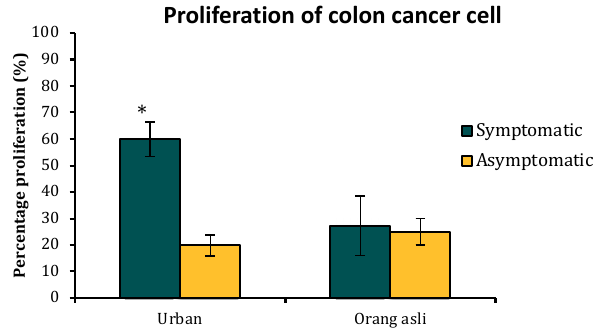
Figure 7. The proliferation of HCT 116 colon cancer cells when treated with solubilized antigens from Blastocystis sp. isolated from urban and orang asli individuals . Colon cells at the density of 1000 cells in 100 μ L were treated with 0.01 μ g/mL of antigen. The proliferation of cancer cells was seen only with isolates obtained from urban symptomatic individuals. Values are expressed as mean ± SD. * p < 0.05 in t -test for comparison within urban isolates and between urban and orang asli